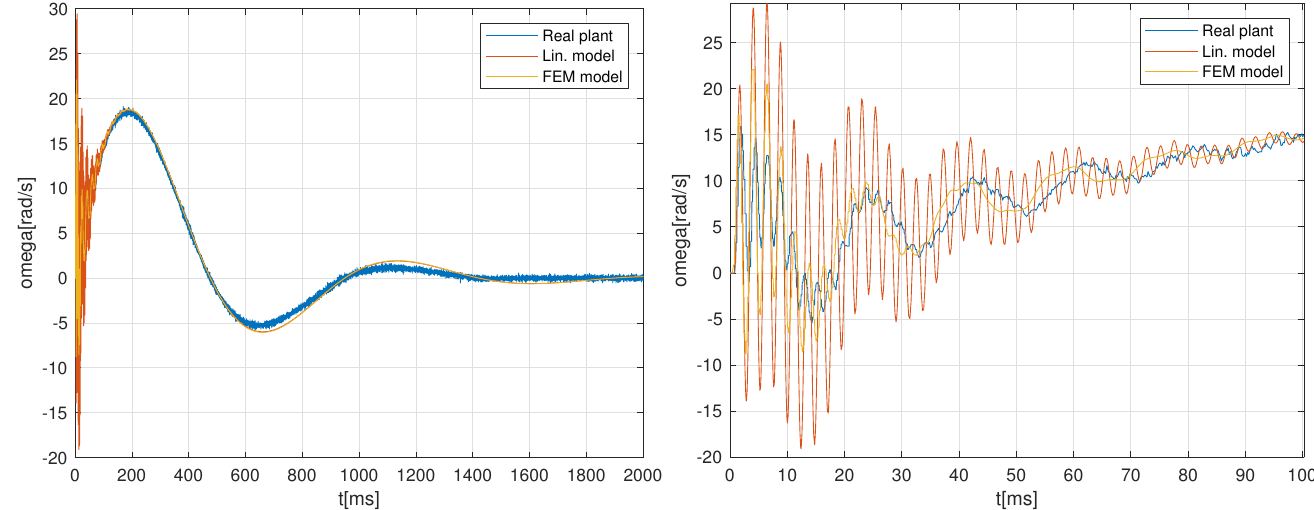
Figure 24. Validation of closed-loop performance: comparison of real plant experimental data with reduced order linear simulation and full-scale nonlinear FEM transient simulation. Left: whole step input disturbance rejection, right: detail of the initial transient.